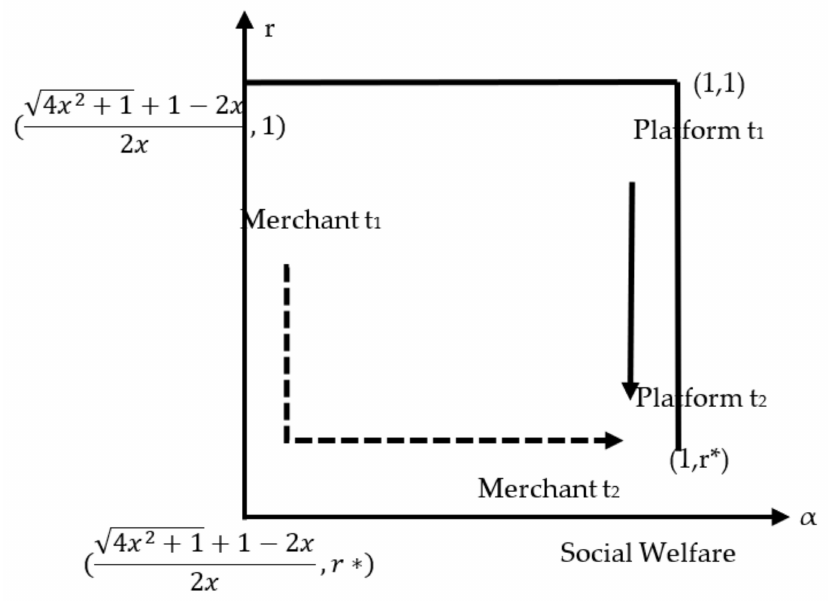
Figure 12. Game equilibrium